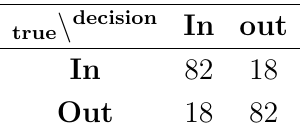
Table 4. Confusion matrix of the classes indoor and outdoor using MAP classifier. The values denote